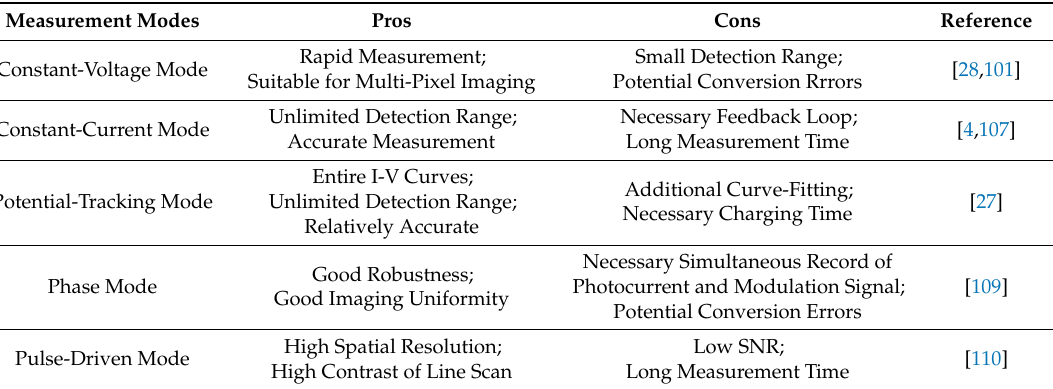
Table 1. Pros and cons of LAPS measurement